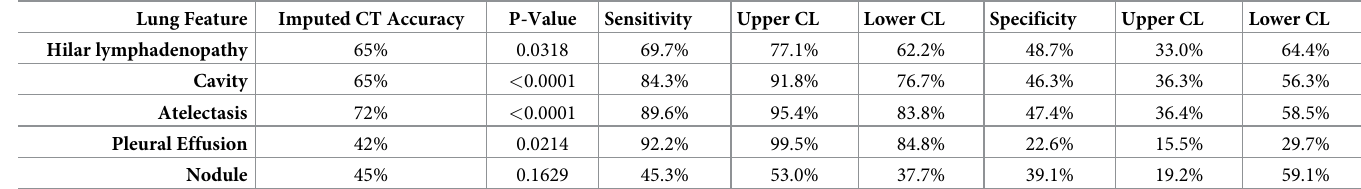
Table 3. 184 TBPP CT Annotations versus Qure.ai Binary Prediction, Crosstabulation Summary Statistics.